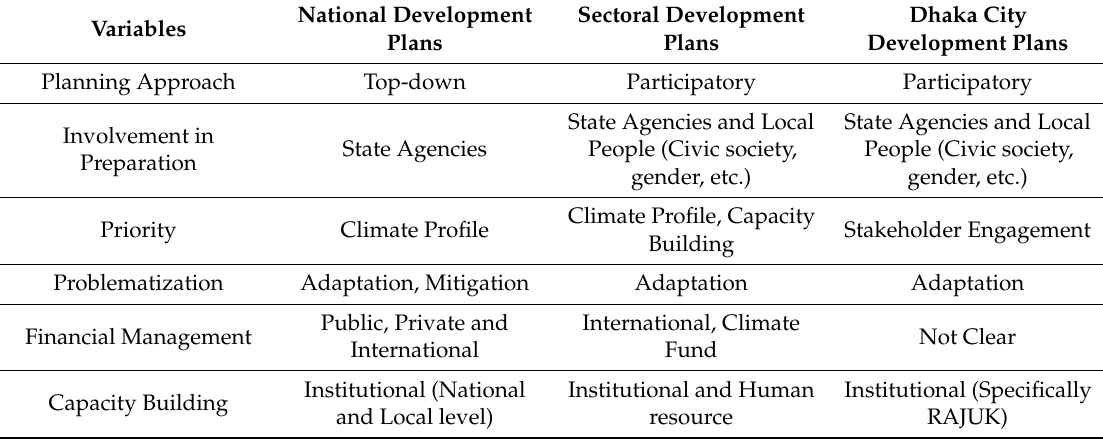
Table 3. The similarities and dissimilarities of selected National, Sectoral, and Dhaka City Development